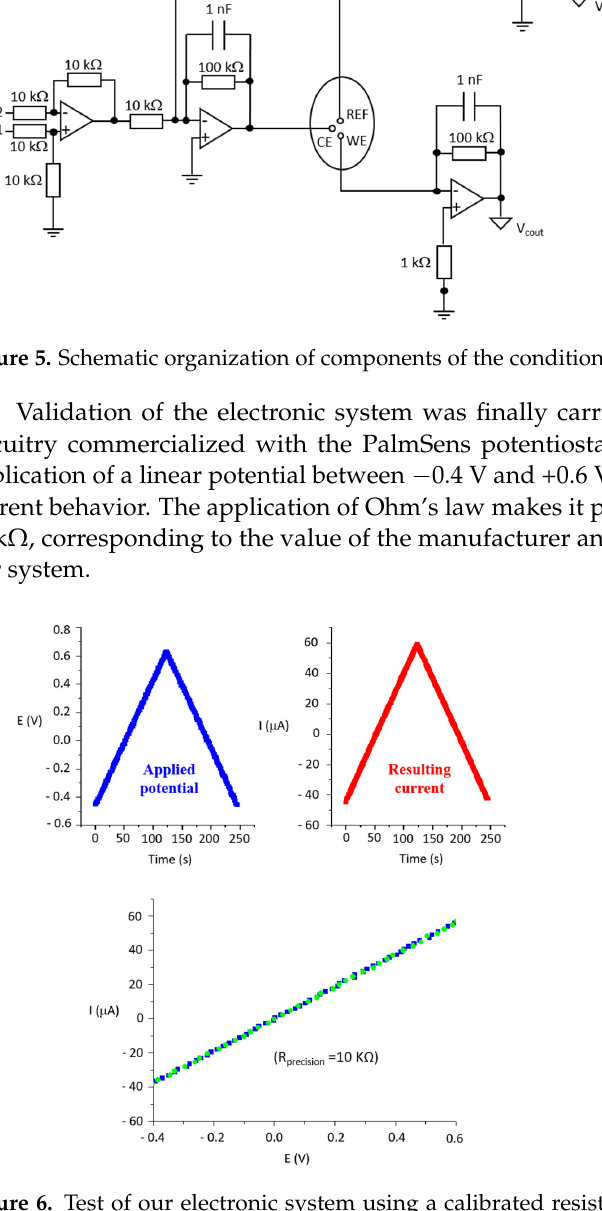
Figure 6. Test of our electronic system using a calibrated resistance of 10 k Ω . ( a ) Triangular E(t) applied potential and resulting I(t) current using the dummy cell; ( b ) Linear I = f(E) relationship in agreement with the Ohm’s law and the value of the resistance.